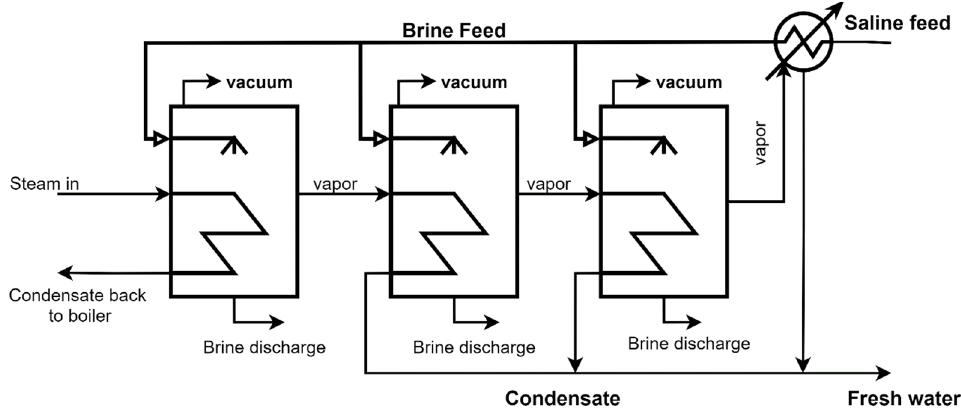
Figure 2. Schematic diagram of MED, amended from [34].